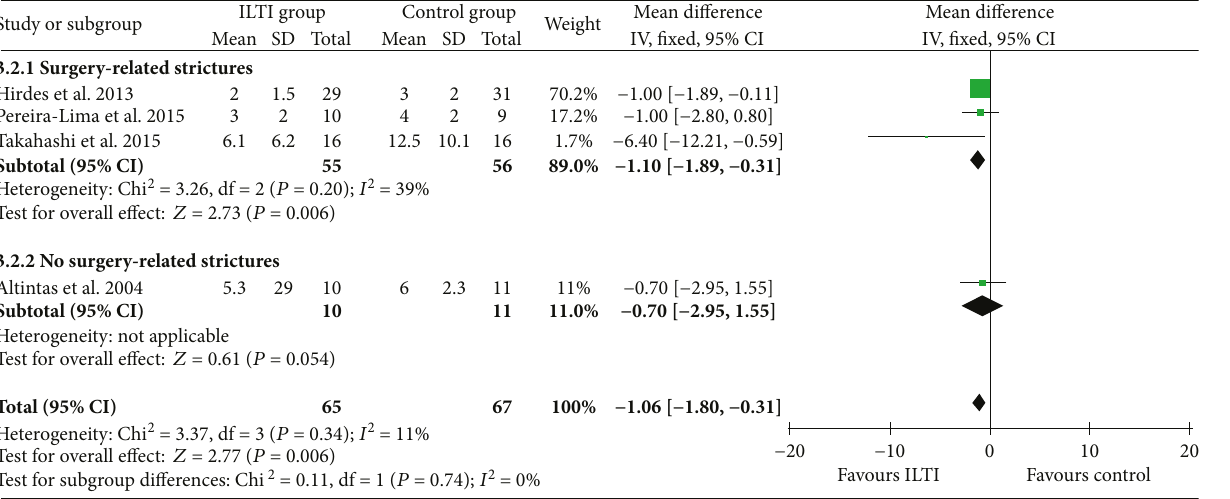
Figure 4: Forest plot of EBD sessions during follow-up between ITI and control.